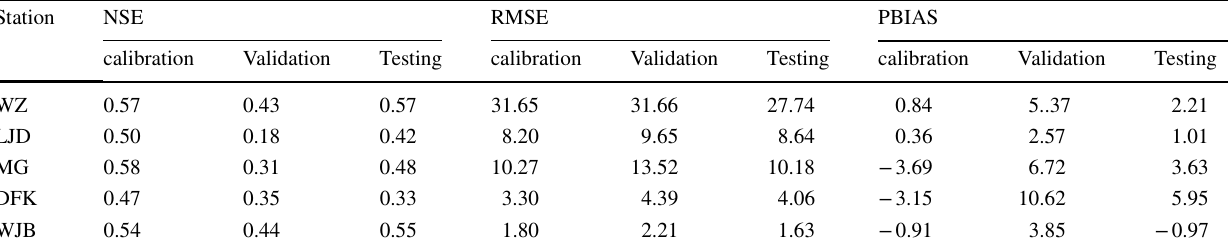
Fig. 17 a NSE and b RMSE of VMD-LSTM model developed based on four sampling tech- niques at WZ